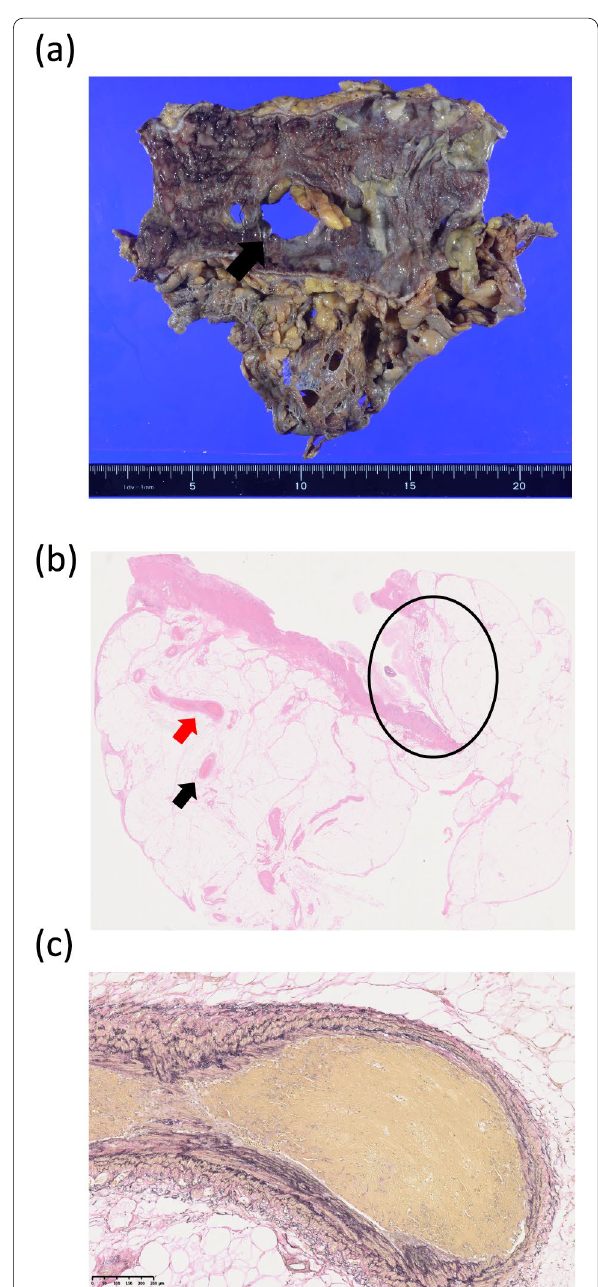
Fig. 4 Pathological findings of the resected specimen. A total of 17 cm of the transverse colon was resected, and 2 perforation sites of 25 and 7 mm in diameter were identified (arrow). The mucosa around the perforation sites was necrotic ( a ). The area enclosed in the circle, shows the perforation site. Microcirculatory thrombosis was found in the mesenteric veins (arrow) ( b , HE staining, 3.9). Higher-power field × of microcirculatory thrombosis in the mesenteric vein, indicated by a red arrow in b ( c , EVG staining, ×